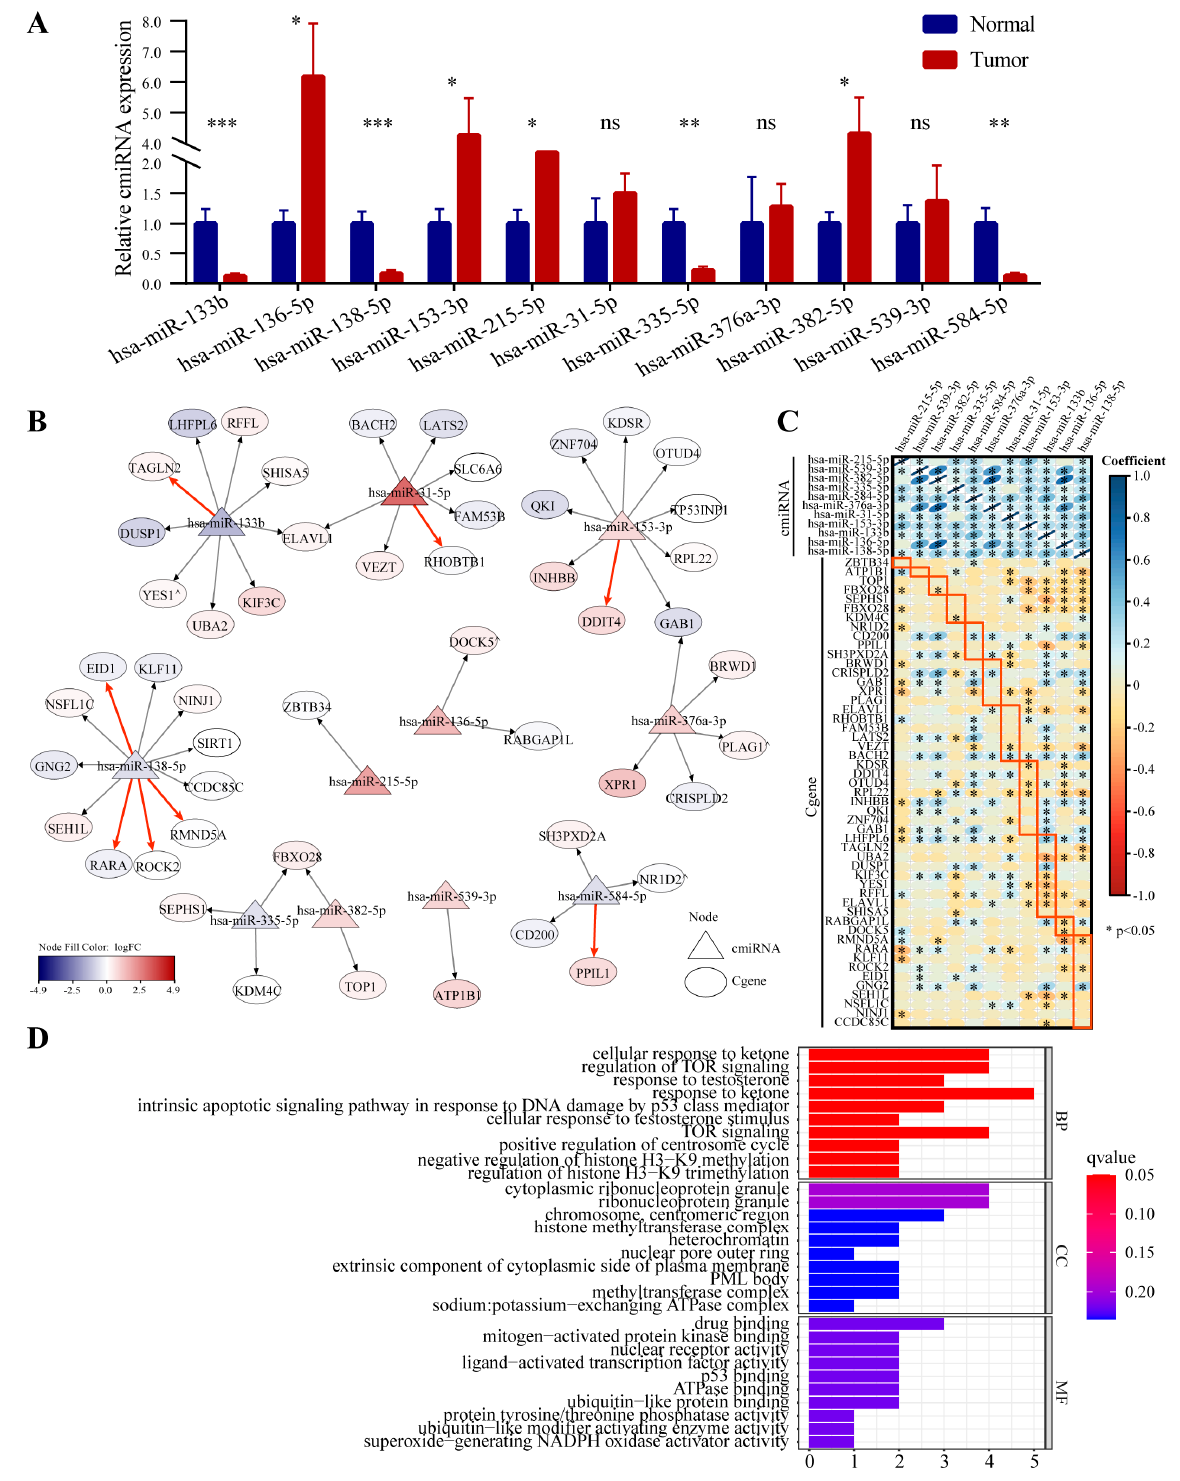
Figure 7. cmiRNA–Cgene network analysis and Gene Ontology (GO) enrichment analysis. ( A ) cmiRNAs of the signature quantification using qRT-PCR in tumor and normal tissues of 11 LUAD patient. ( B ) cmiRNAs and targeted-Cgenes network analysis (blue, white, and red mean lower, equal and higher expression level of cmiRNAs/Cgenes in tumor comparing to normal tissues, respectively, all p < 0.05 except that ˆ p > 0.05, the red arrows indicate experimentally validated targeting regulatory relationships retrieved from the miRWalk database). ( C ) Spearman correlation analysis between miRNA expression and target genes in TCGA-LUAD cohort, the red box marks the target Cgene corresponding to each column of cmiRNA ( D ) GO enrichment analysis of the tar- geted Cgenes. (ns, not significant; * p < 0.05; ** p < 0.01; *** p < 0.001).